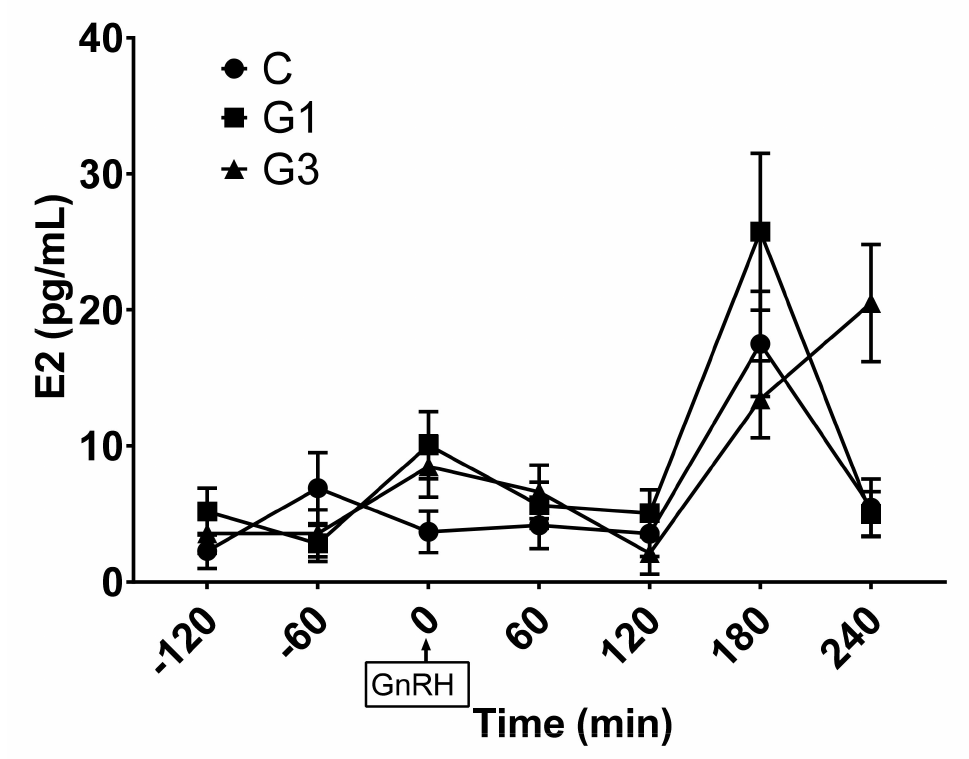
Figure 2. Plasma estrogen (E2) concentrations from minutes − 120 to 240 after GnRH injection in the control group (C) and does supplemented with 1% (G1) or 3% (G3) of Goji. Values are means and standard